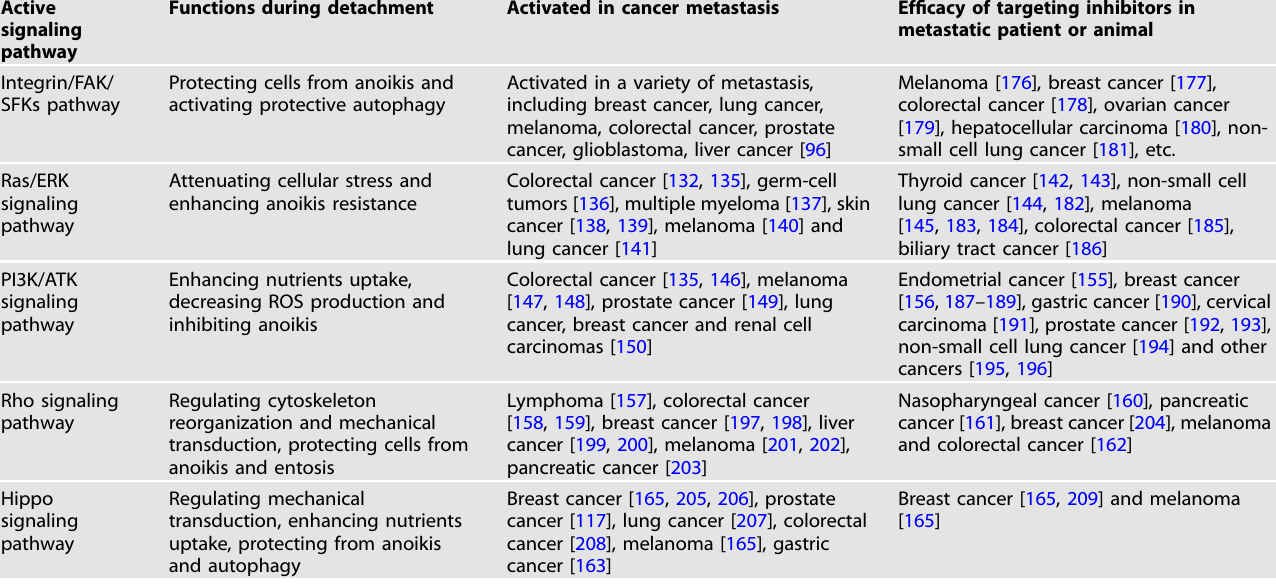
Table 1. The role of signaling pathways in anchorage-independent survival and their implication in the treatment of cancer